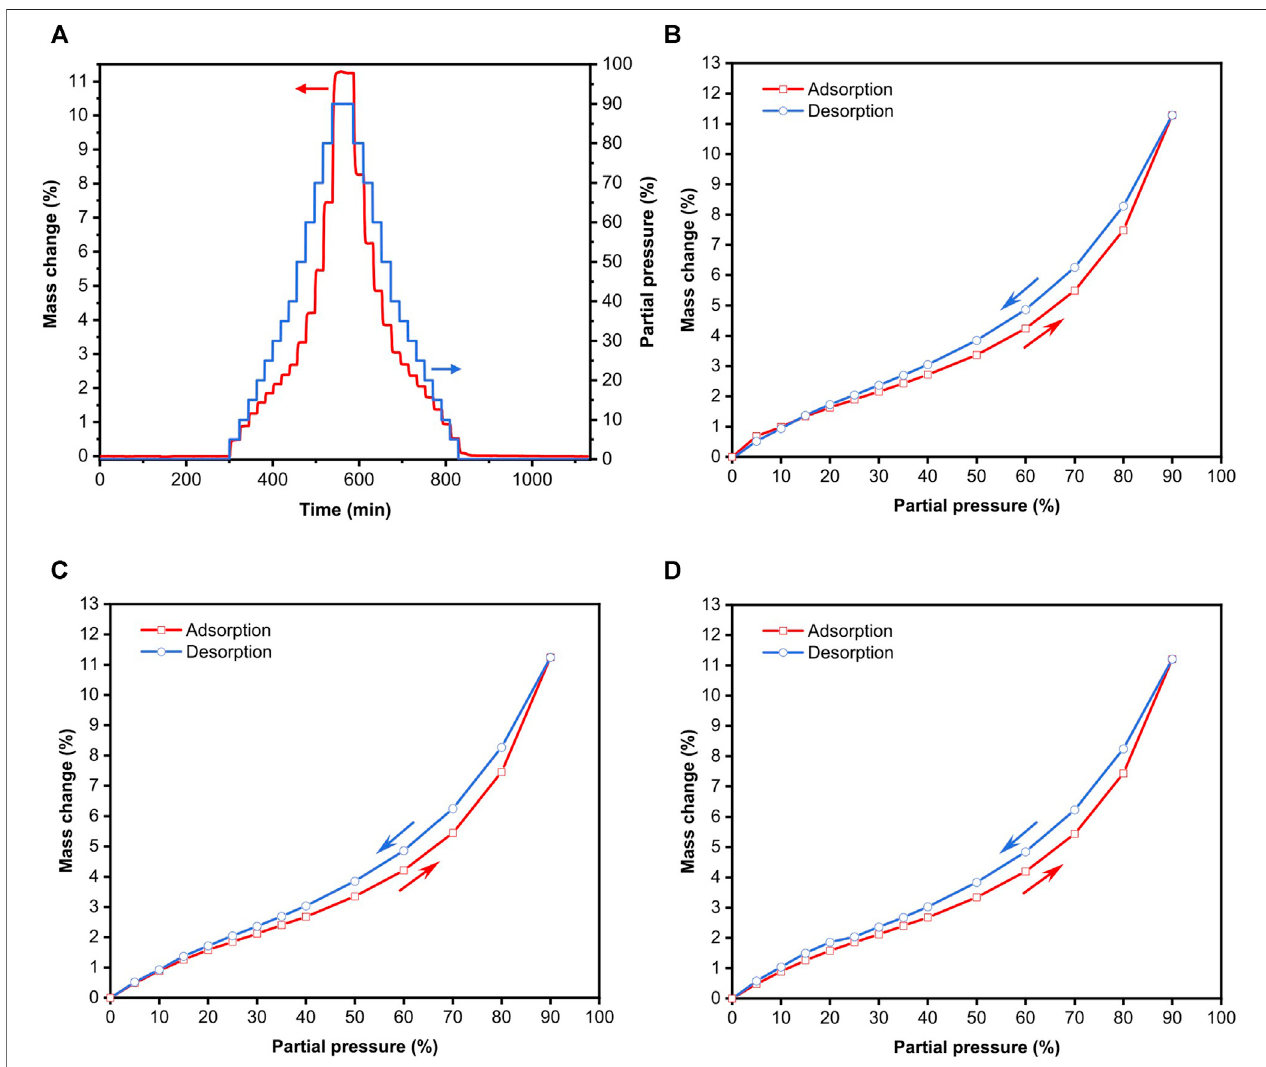
FIGURE 3 | n-Octane adsorption-desorption isotherms on freeze-dried BC measured using DVS. (A) Experimental mass change as a function of time due to n-octaneadsorption-desorption, (B) fi rstadsorption-desorption runimmediately after pre-conditioning, (C) secondadsorption-desorptionimmediatelyafterthe fi rstrun and (D) third adsorption-desorption run immediately after the second